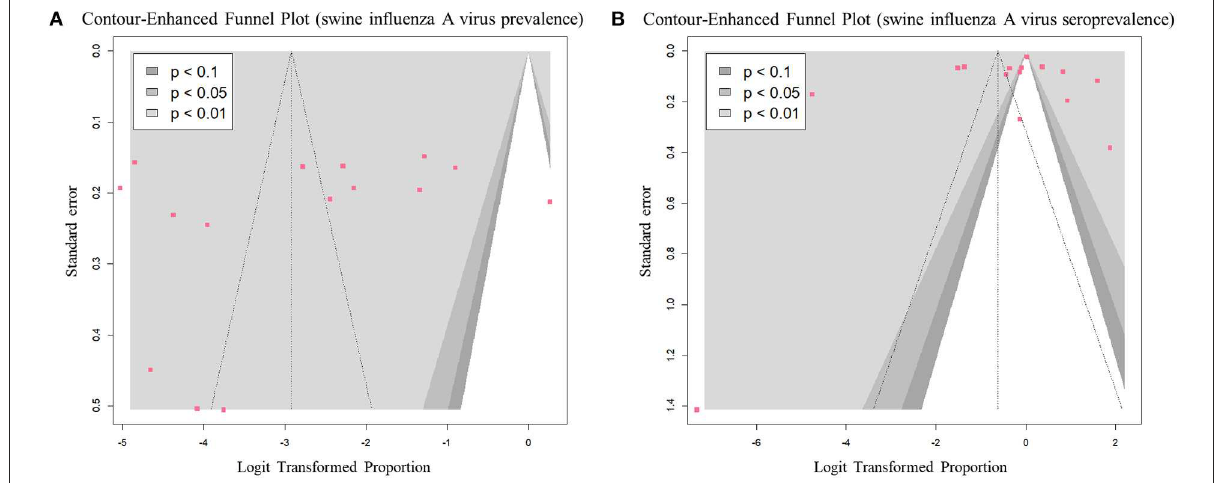
FIGURE7 Contour-enhanced funnel plots of eligible studies for each outcome: (A) prevalence of swine influenza A virus (swIAV) and (B) seroprevalence of swIAV in South Korean domestic